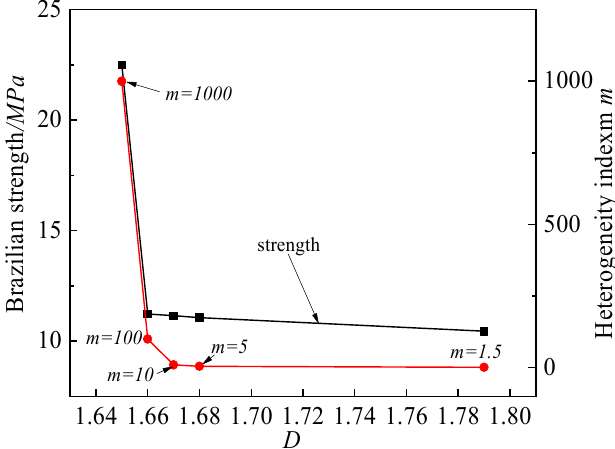
Figure 13. Numerical simulation of Brazilian splitting for heterogeneous model. ( a ) m = 1.5; ( b ) m = 5; ( c ) m = 10; ( d ) m = 100; ( e ) m = 1000.